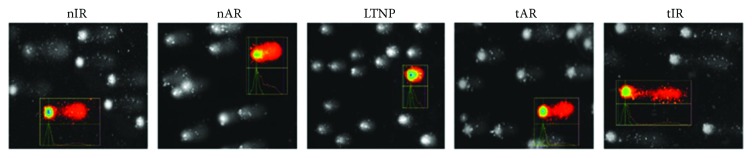
Leukocyte DNA damage representation of five selected nucleoids of patients living with HIV/AIDS, according to the five study groups, whose slides were treated with the formanodipirimidina-DNA glycosylase (FPG) enzyme. By the analysis of the Comet assay, the immunofluorescence microscopy shows that LTNP presents less damage than the other groups.